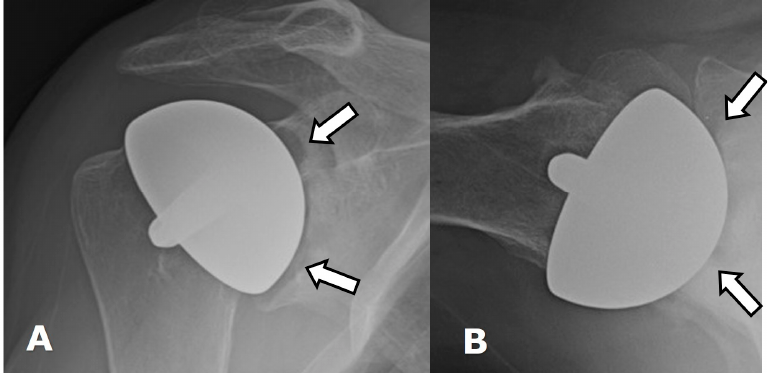
Figure 13. ( A ) Frontal and ( B ) axillary radiographs show glenoid wear with erosions (arrows) in a patient with an